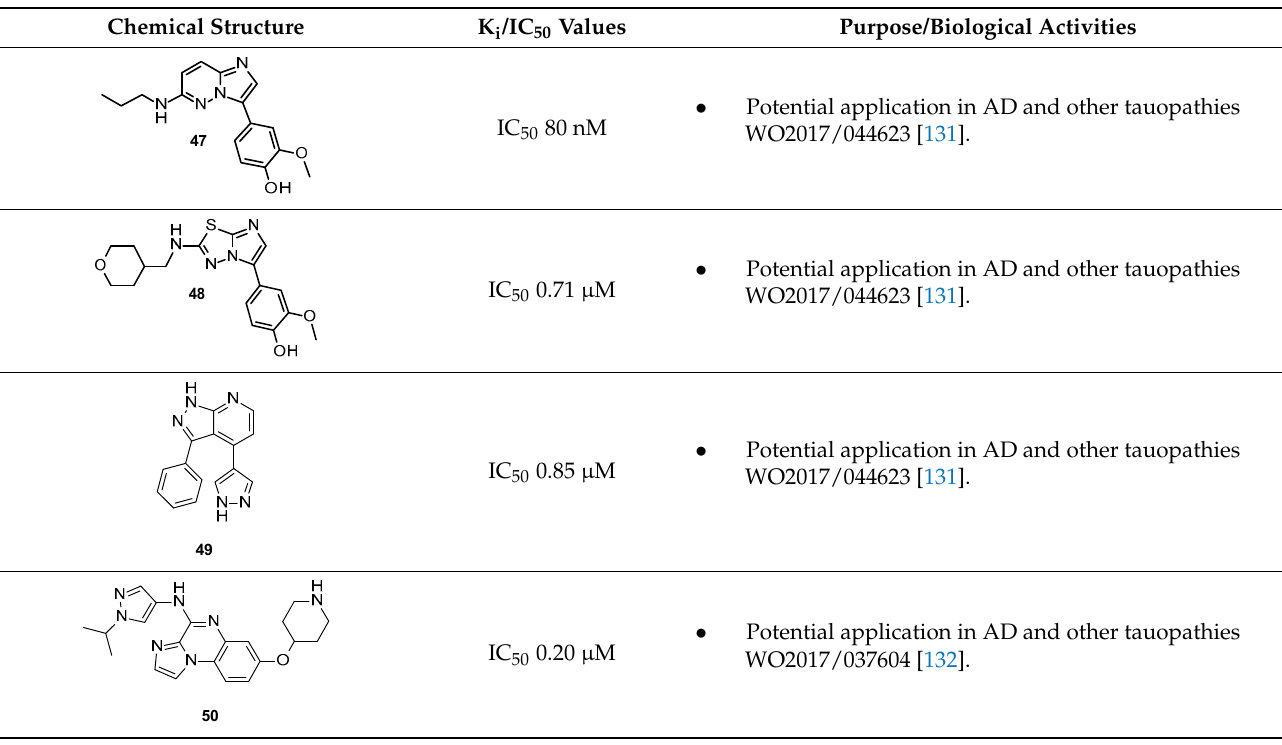
Table 3. ATP-competitive DYRK1A inhibitors and their applications. Chemical Structure